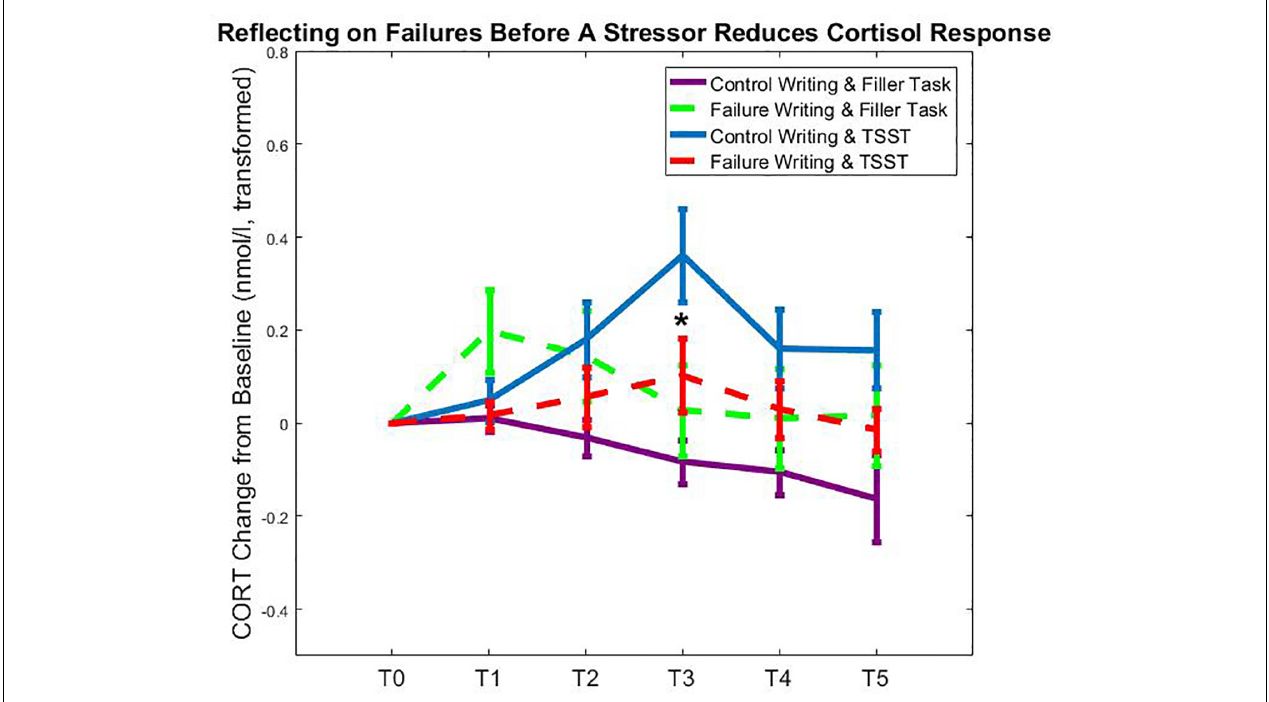
FIGURE 2 | Results. T0 = baseline; T1 = finish writing, 15 min since baseline; T2 = 10 min since stressor onset, 35 min since baseline, expected peak cortisol after writing; T3 = 30 min since stressor onset, 55 min since baseline, expected peak cortisol after stressor; T4 = 45 min since stressor onset, 70 min since baseline; T5 = 60 min since stressor onset, 85 min since baseline. Participants who were subjected to the psychosocial stressor exhibited cortisol increases from baseline (blue line), especially at peak cortisol since stressor conclusion (T3); however, participants who reflected on failures before experiencing the psychosocial stressor exhibited a reduced cortisol response (red line). Participants did not exhibit significant differences at peak cortisol since completing our writing manipulation (T2). Cortisol values represent transformed and baseline-adjusted values (see section “Materials and Methods”).